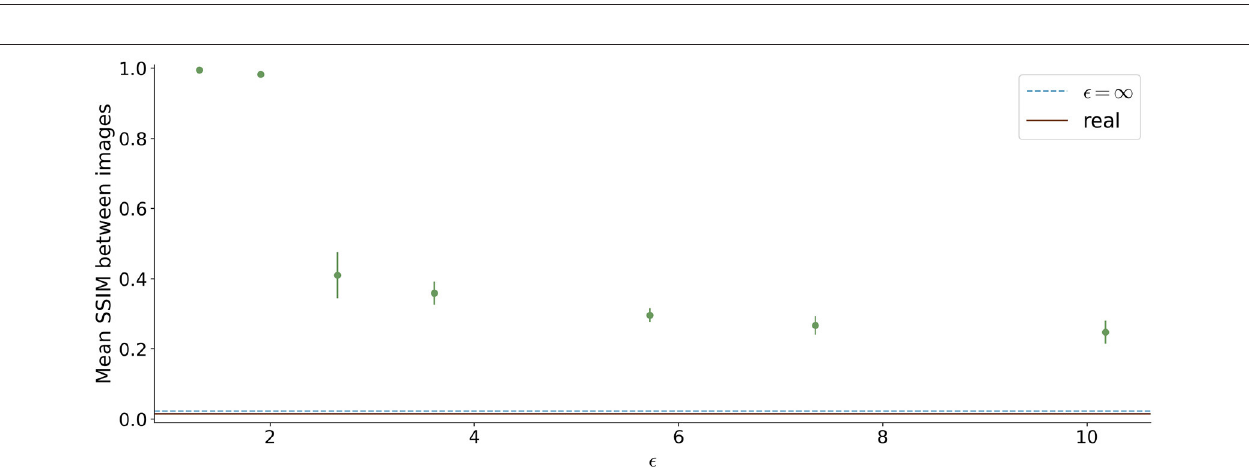
FIGURE 7 | Segmentation error maps of one test patient by the best U-Net model using differential privacy ( ǫ = 7.4). Red indicates the true positives, green stands for false positives, and yellow for false negatives. (A) shows a slice containing big vessels, (B) small ones, and (C) the whole vessel tree. The segmentation works reasonably well with errors occurring particularly when segmenting small vessels.